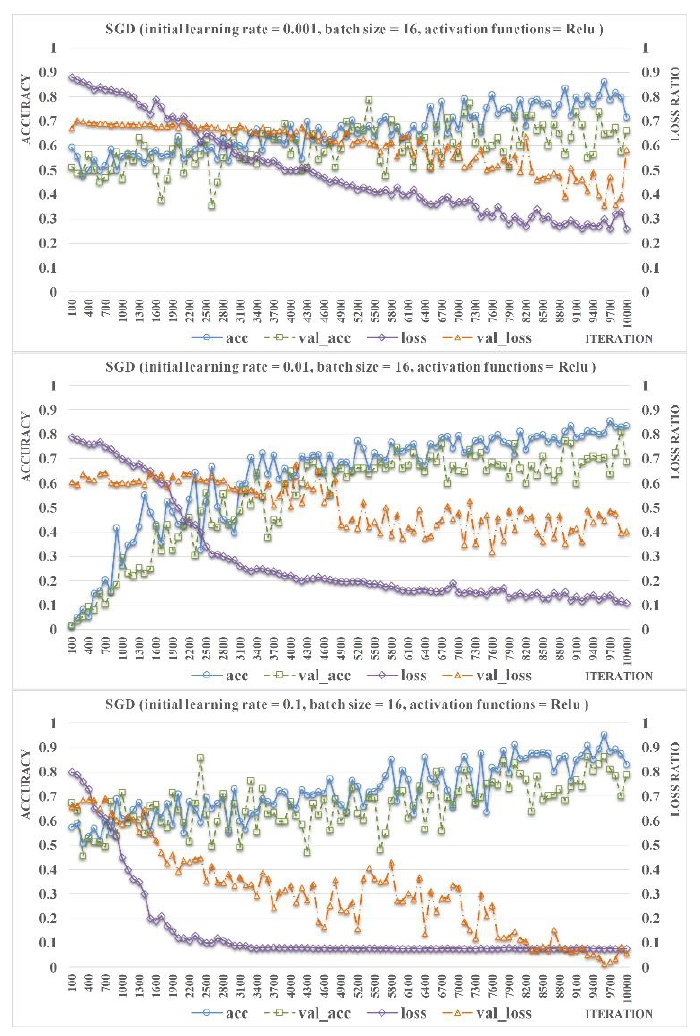
Figure 6. Comparison of the accuracy rate and the loss rate of ResNet-Locust-BN based on different initial learning rates (activation function = ReLU, batch size = 16).